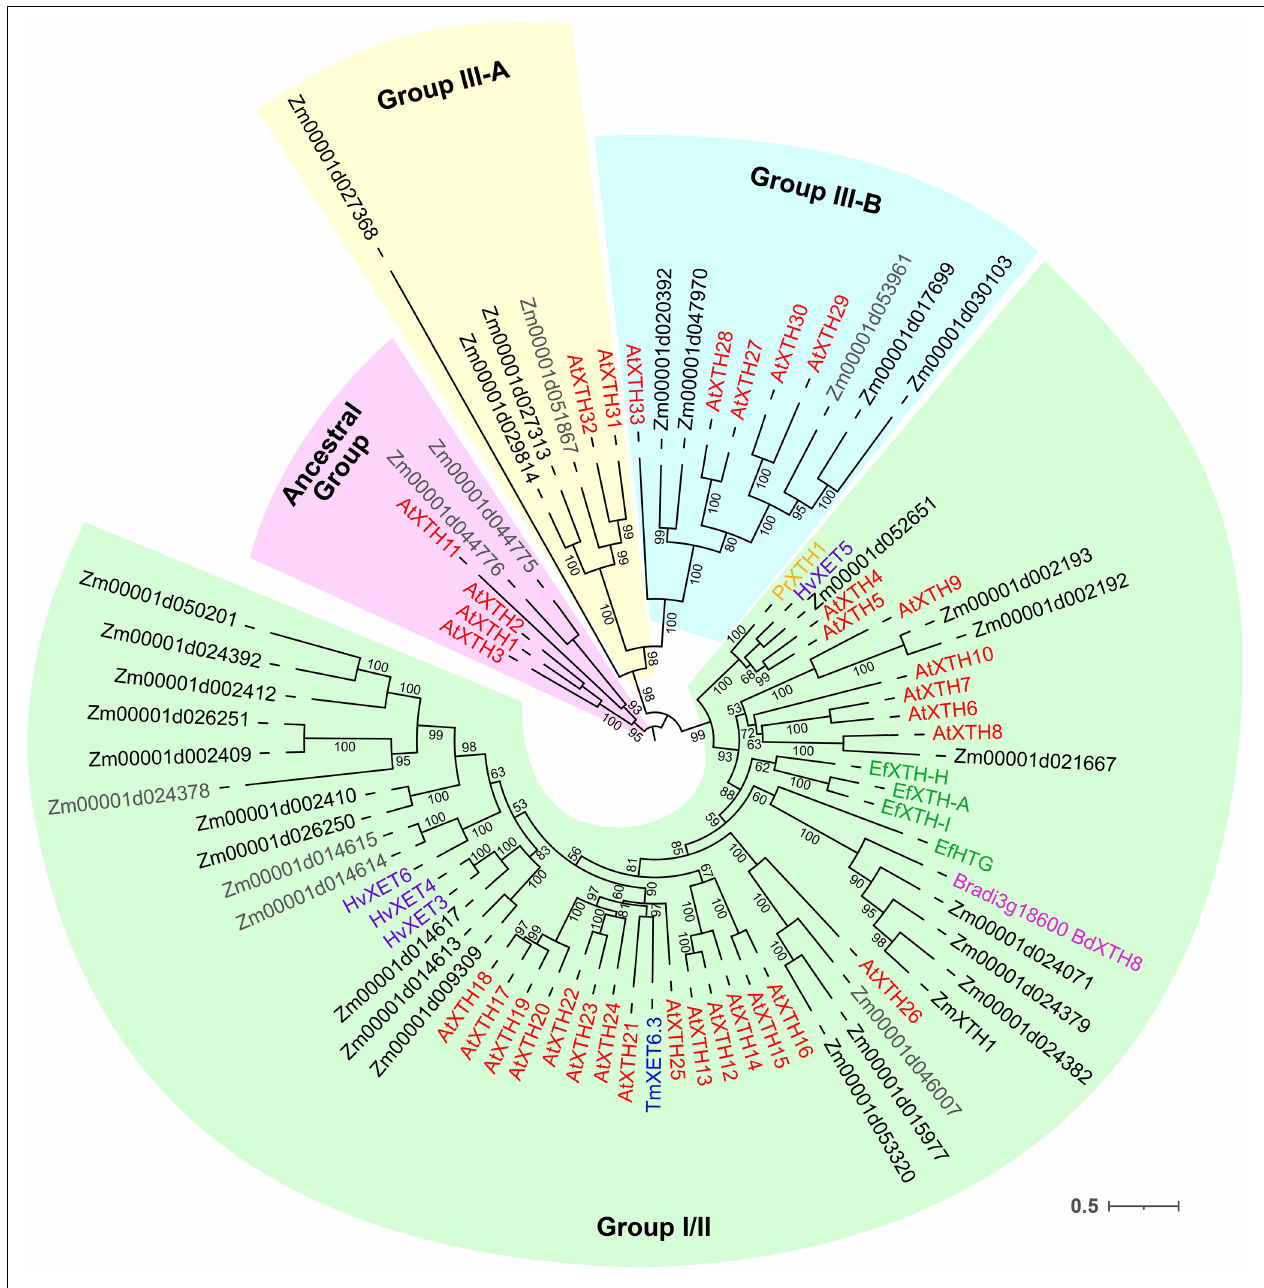
FIGURE 7 | Unrooted maximum likelihood phylogenetic analysis of the plant GH16 family. Maize genes are given in black font for expressed genes and gray for those having TGR values lower than 16 in all the analyzed root samples, and Arabidopsis thaliana genes are given in red. Characterized XTHs of barley (Hrmova et al., 2007, 2009), Equisetum (Herburger et al., 2021), nasturtium (Crombie et al., 1998), and Brachypodium (Fan et al., 2018) are shown in purple, green, blue, and magenta, respectively. Numbers indicate ultrafast bootstrap support values for some branches.